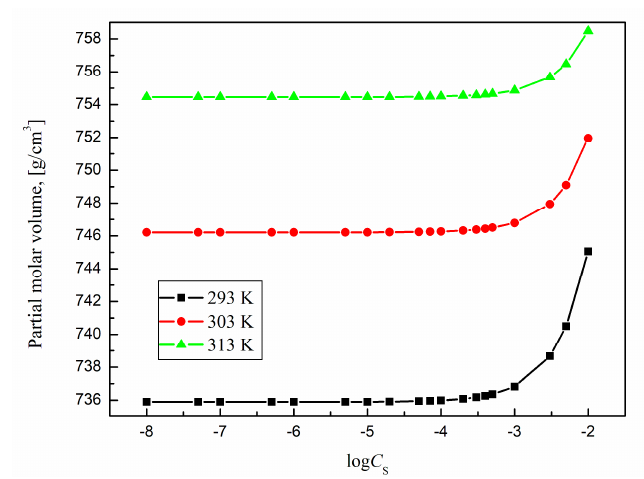
Figure 17. The partial molar volume ( V M ) of TS-OE12 vs. the logarithm of its concentration (log C S ) at 293 K, 303 K and 313 K.